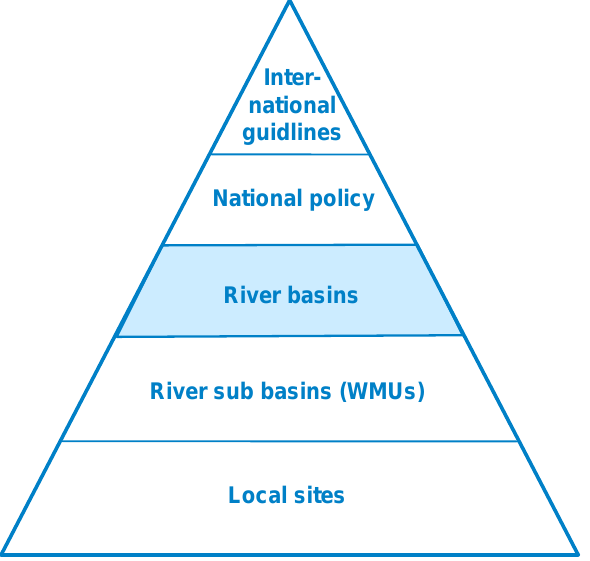
Figure 2. Planning levels of the research project